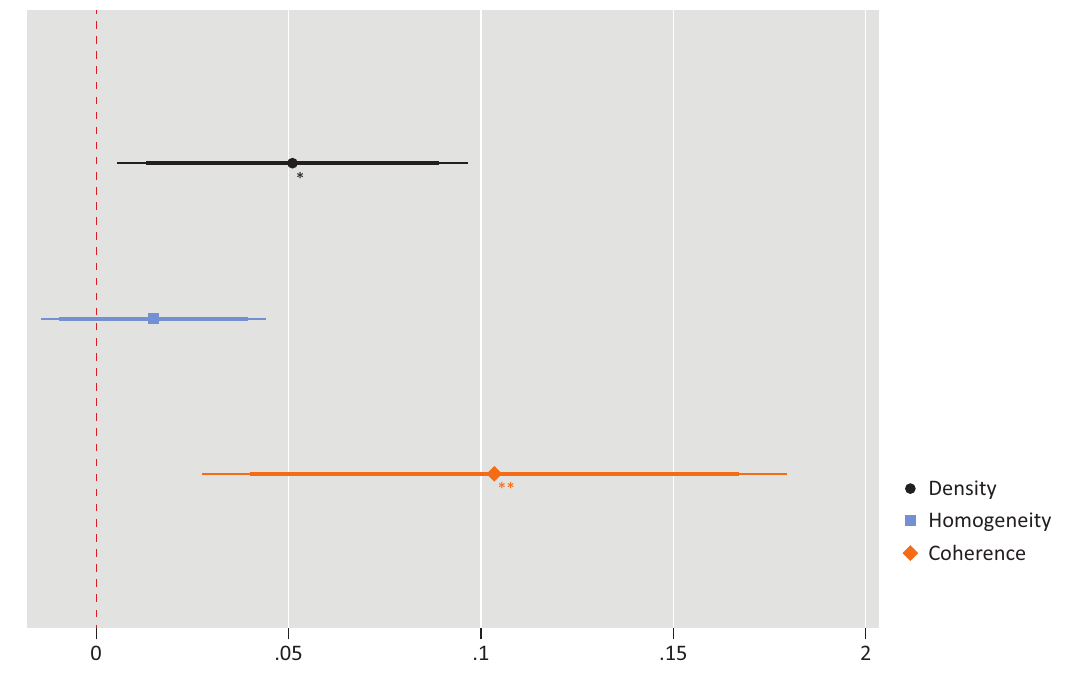
Figure 1. News congeniality effects on discussion network properties. Notes: network density is based on the average strength of ties among all alters (N = 661). Network homogeneity is based on shared partisan affiliation between partic- ipants and alters (N = 786). Network coherence is based on average ideological distance of alters from the participant (N =